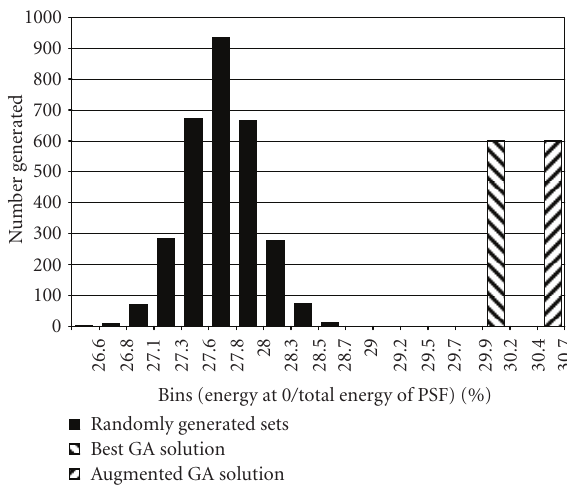
Figure 3: Comparison of randomly selected trajectory sets versus solutions from the GA. Note that the banded bars indicate horizontal position not counts.